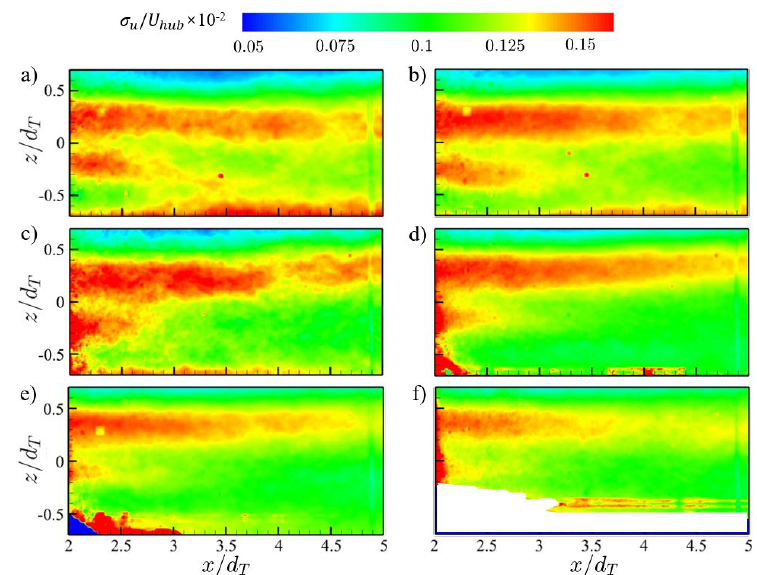
Figure 5. Turbulence intensity distribution, σ u / U hub , in the center plane ( y = 0) for the backward- and forward-facing step cases and flat terrain with ∆ z 0 / d T equal to: ( a ) − 0.64; ( b ) − 0.42; ( c ) − 0.21; ( d ) 0; ( e ) 0.21; and ( f ) 0.42.